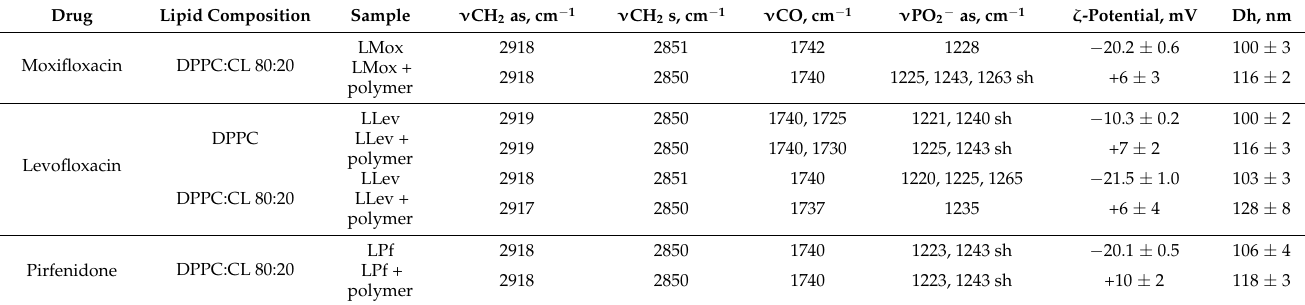
Table 3. Main band position on the ATR-FTIR spectra of liposomal forms of drugs and its complexes with mannosylated chitosan. Total lipid concentration 3 mg/mL. 0.02 M Na phosphate-buffered solution, pH 7.4, 22 ◦ C. Spectral resolution 1 cm − 1 . Shoulders of bands are marked with “sh”. For DPPC:CL 80:20 liposomes, the base molar ratio with Mannosylated chitosan is 1:7 in terms of phosphate groups of cardiolipin and free amino groups of chitosan. For liposomes of a different composition, the same proportions of the components of the complex are